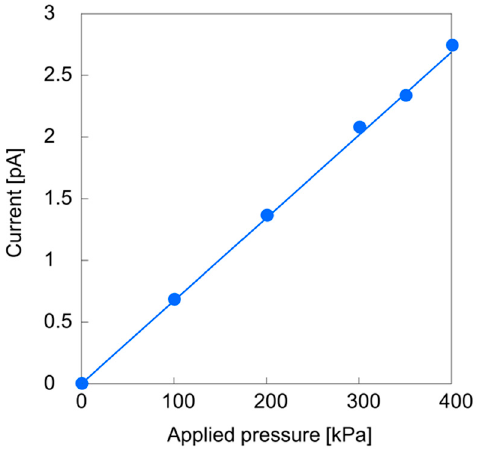
Figure 4. Results of streaming current measurements based on the analysis of 100 nanochannels with dimensions of 48 nm (width), 49 nm (depth) and 200 mm (length).